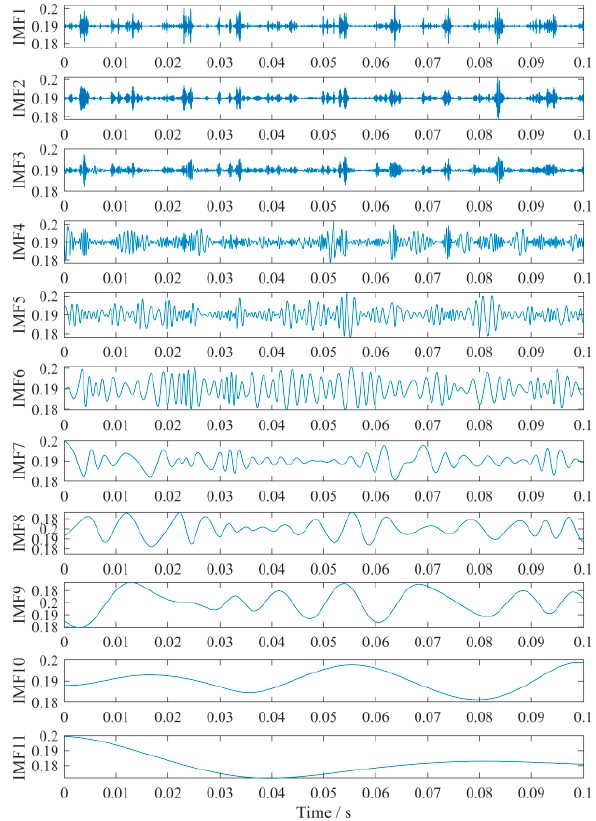
Figure 6. Decomposition results of the cutting sound signal.